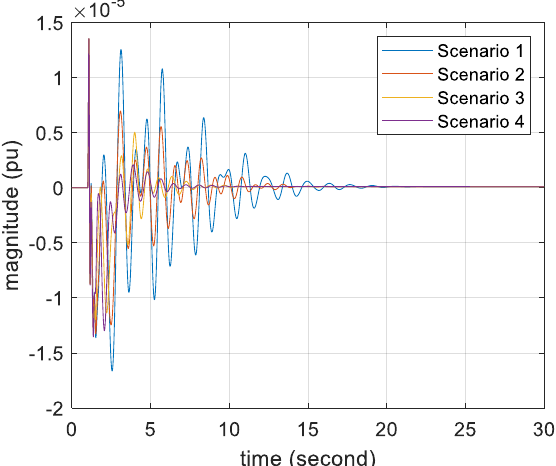
Figure 12. Q-axis current responses of wind generation.